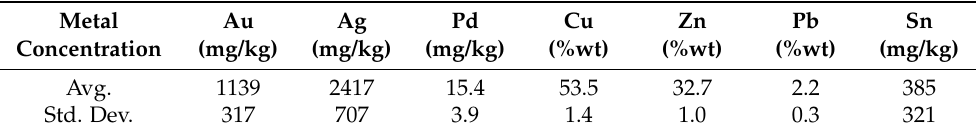
Table 1. Average (Avg.) concentration and standard deviation (Std. Dev.) of metals in connectors, sample 1.